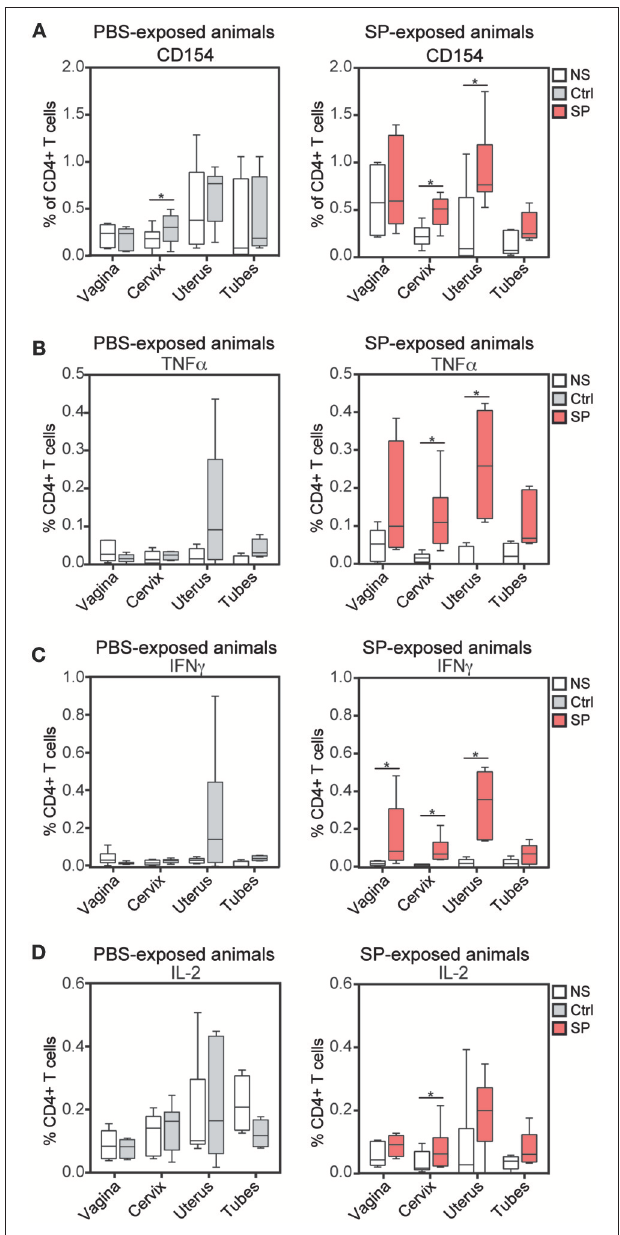
FIGURE 1 | SP exposure enhances vaccine-specific mucosal CD4 + T cell responses. Percentage of CD154 + (A) , TNF- α + (B) , IFN- γ + (C) , and IL-2 + (D) cells among CD4 + T cells after in vitro stimulation with medium (white) or wt MVA (gray for control animals, left panel and red for SP exposed animals, right panel) in FRT tissues. The Wilcoxon signed rank test (*) was used to compare NS vs. wt MVA stimulation antigens (* p < 0.05).